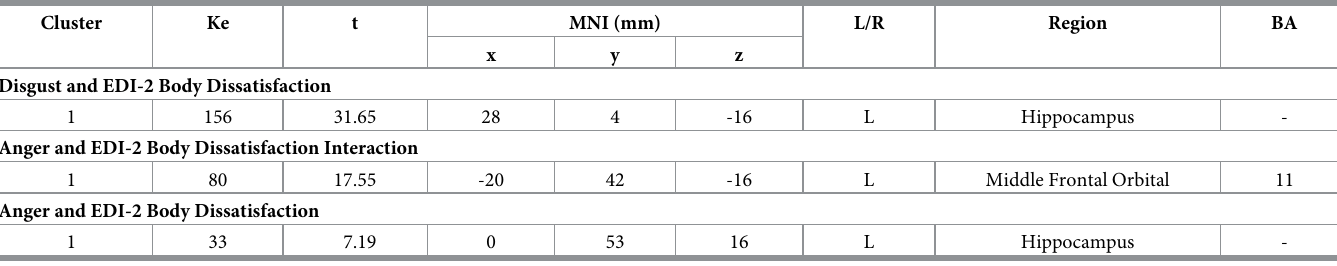
Table 5. Correlation